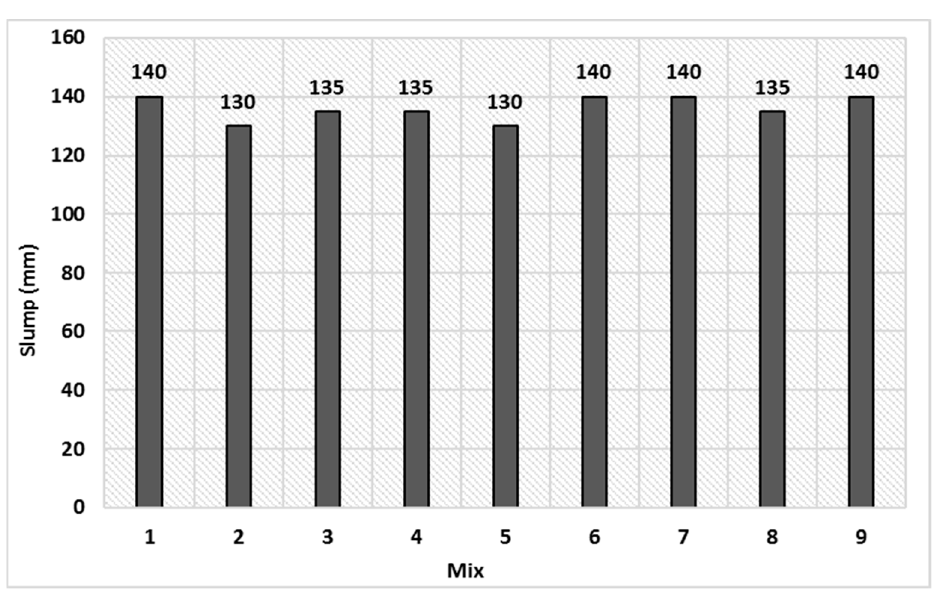
Figure 3. Measured slump values for all mixes in this